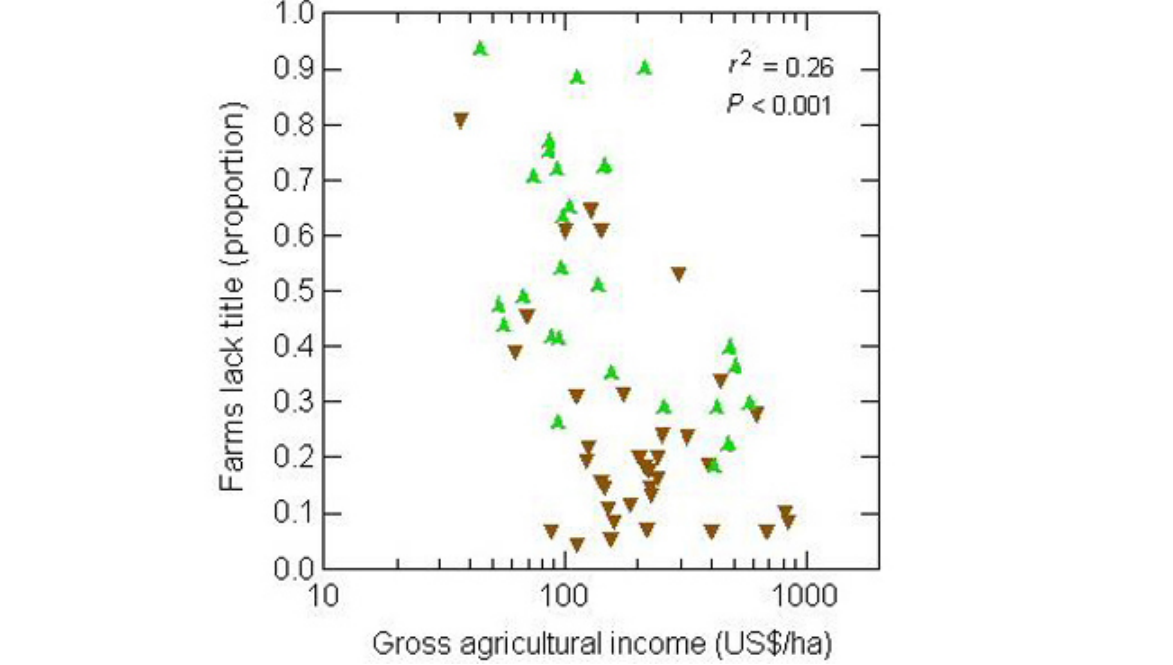
Fig. 10. The relationship between the proportion of farms that lack land titles and gross income from all agricultural activity for 62 districts in Panama. Brown downward-pointing triangles indicate districts that were largely deforested before 1947; green upward-pointing triangles indicate districts that were largely forested in